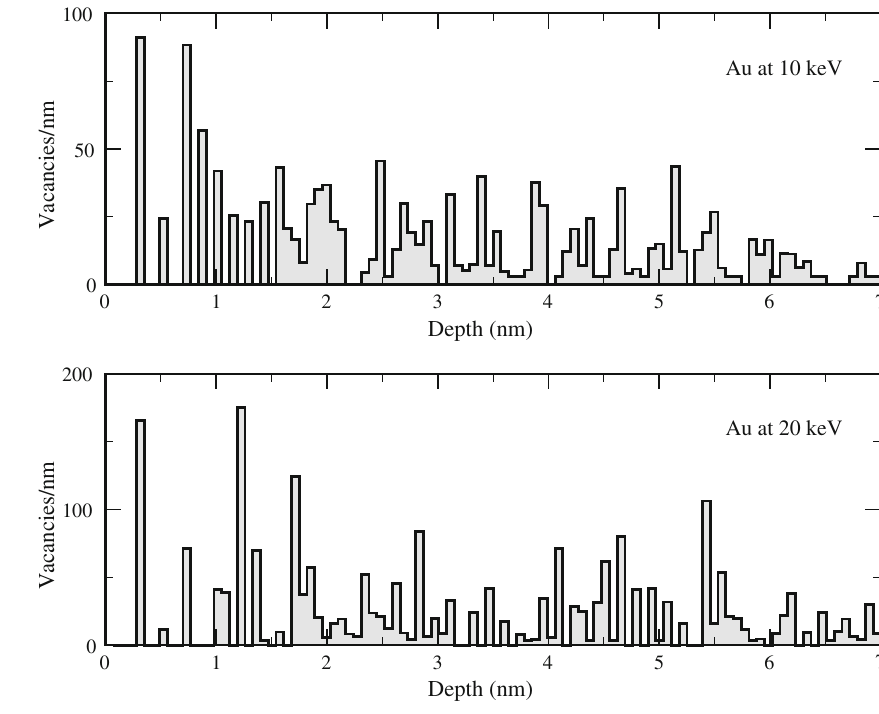
Fig. 3 Plot of SRIM simulated number of primary and secondary vacancies per nm of depth in the graphene/h-BN heterostructure as a function of recoiling Au nucleus depth in the heterostructure. The vacancies are produced by a recoiling Au nucleus entering at 10 (upper) and 20 keV (lower) in the direction perpendicular to the heterostructure. The simulations were done by approximating the graphene/h-BN heterostructure by a 7-nm-thick layer of C, B, and N with a stoichiometric ratio of